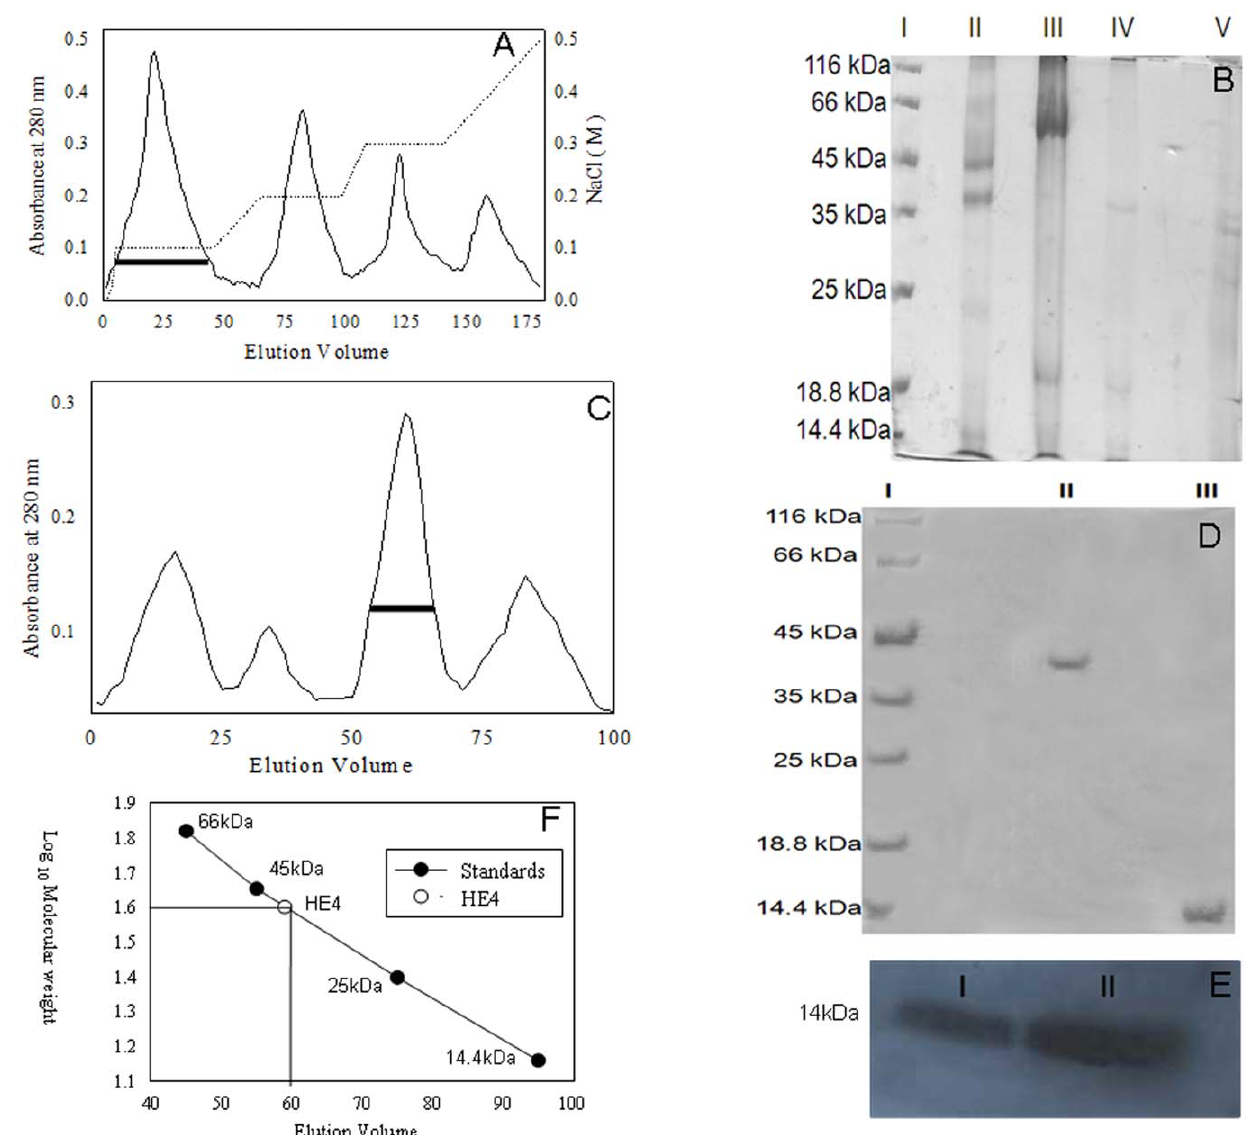
Figure 1. Purification of HE-4 protein from human seminal plasma using affinity, ion exchange and gel filtration chromatography. ( A ) Elution profile of anion exchanger DEAE sephacel. The peaks formed as a function of X-axis as elution volume in ml and Y-axis is mA at 280 nm. The second (….) line represents the gradient of NaCl. The first peak with black base given is the one where we found HE-4. ( B ) 12.5% SDS-PAGE of peaks obtained from anion exchanger DEAE sephacel. Lane I: Protein marker. Lane II: Elution profile of First peak in which we obtained HE-4 with other impurities. Lane III, IV and V: Elution profile of second, third and fourh peak respectively. ( C ) Elution profile of Sephadex G-75. The peaks were obtained as a function of X axis as elution volume in mL and Yaxis is mA at 280 nm. Buffer used for elution is 50 mM Tris-HCl pH 8.0 and 0.2 M NaCl. ( D ) 12% SDS-PAGE of the third peak of elution profile of sephadex G-75. Lane I: Protein Marker. Lane II: Elution of the third peak in non-reducing condition and Lane III: Elution profile of a third peak in reducing conditions. ( E ) Immunodetection of HE-4 in crude seminal plasma and of the third peak of elution profile of sephadex G-75. Lane I: Crude seminal plasma. Lane II: Purified protein (IIIrd peak of sephadex G-75). ( F ) The standard curve for Sephadex G-75 and lines drawn for the position of HE-4 in the standard